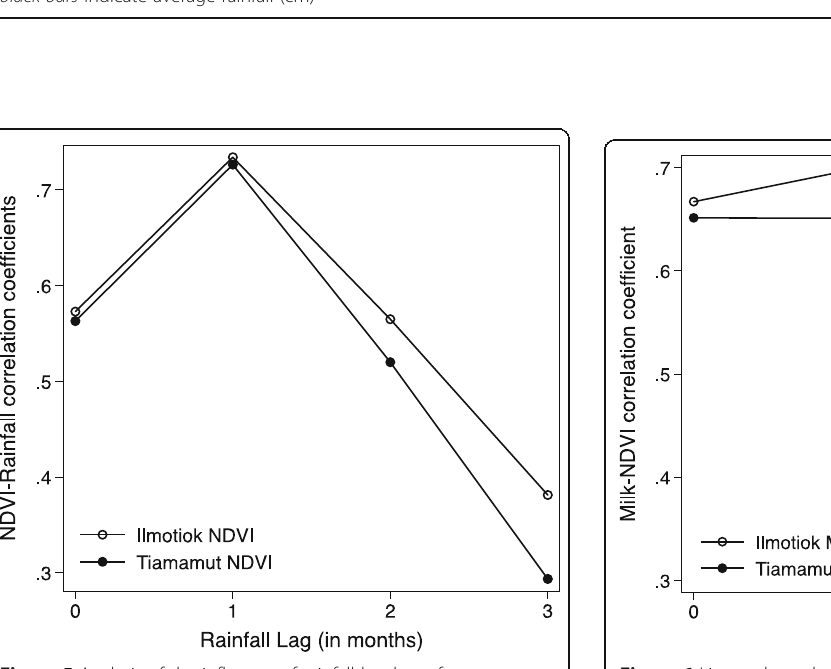
Figure 5 Analysis of the influence of rainfall levels on forage production in Ilmotiok. The correlation between NDVI and rainfall is highest at a lag of one month ( R 2 = 0.72, p < 0.05). Thus, forage